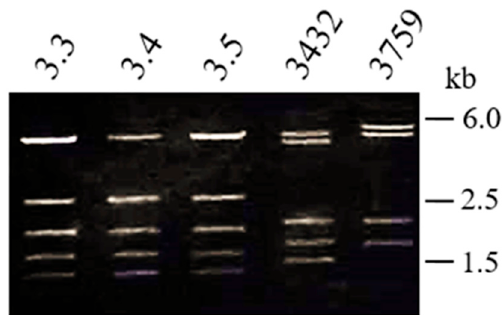
Figure 2. Enzymatic digestion of the pRAS3 plasmids in E. coli DH5 α . The enzymes SalI -HF and ClaI were used.